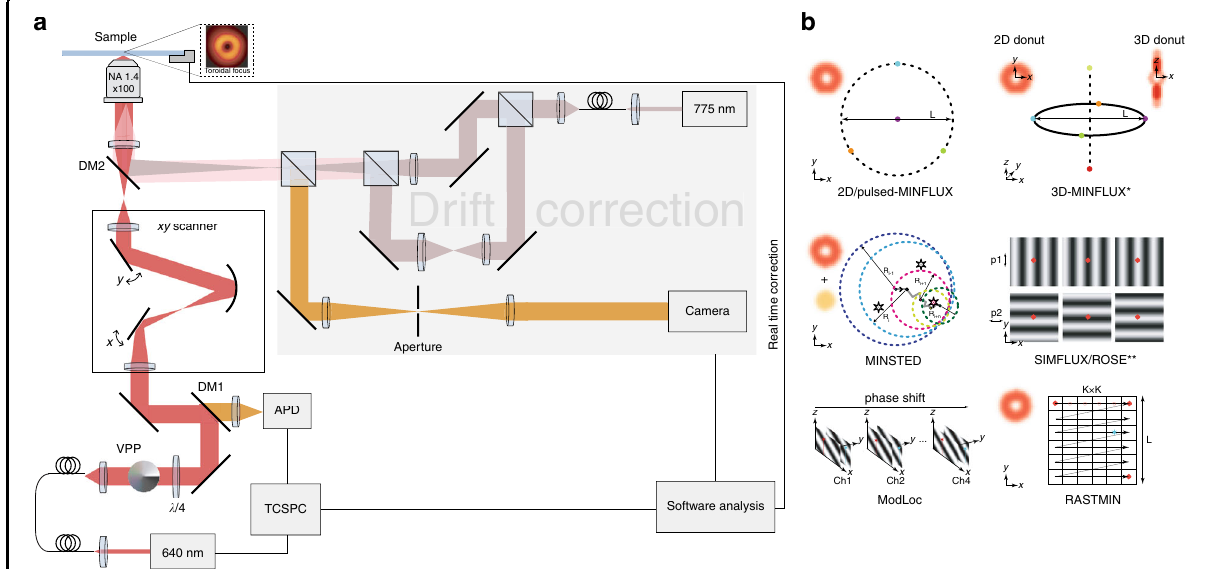
Fig. 1 RASTMIN setup illustration and the main modulation patterns in some selected sequentially structured illumination(SSI)-based techniques. a RASTMIN setup consists of excitation with donut modulation, xy-scan, drift correction and time-related single photon detection modules which has high compatibility with scanning-based fl uorescent microscope, if starting from the experience on STED construction. b Structured excitation in 2D-MINFLUX 13 , pulsed-MINFLUX 15 , 3D-MINFLUX 14 , MINSTED 21 , SIMFLUX 20 , ROSE 19 , ModLoc 22 , and RASTMIN 16 , respectively. * Regular focus is not displayed. ** Only crucial coherent modulation is illustrated; the delicate control and difference are not